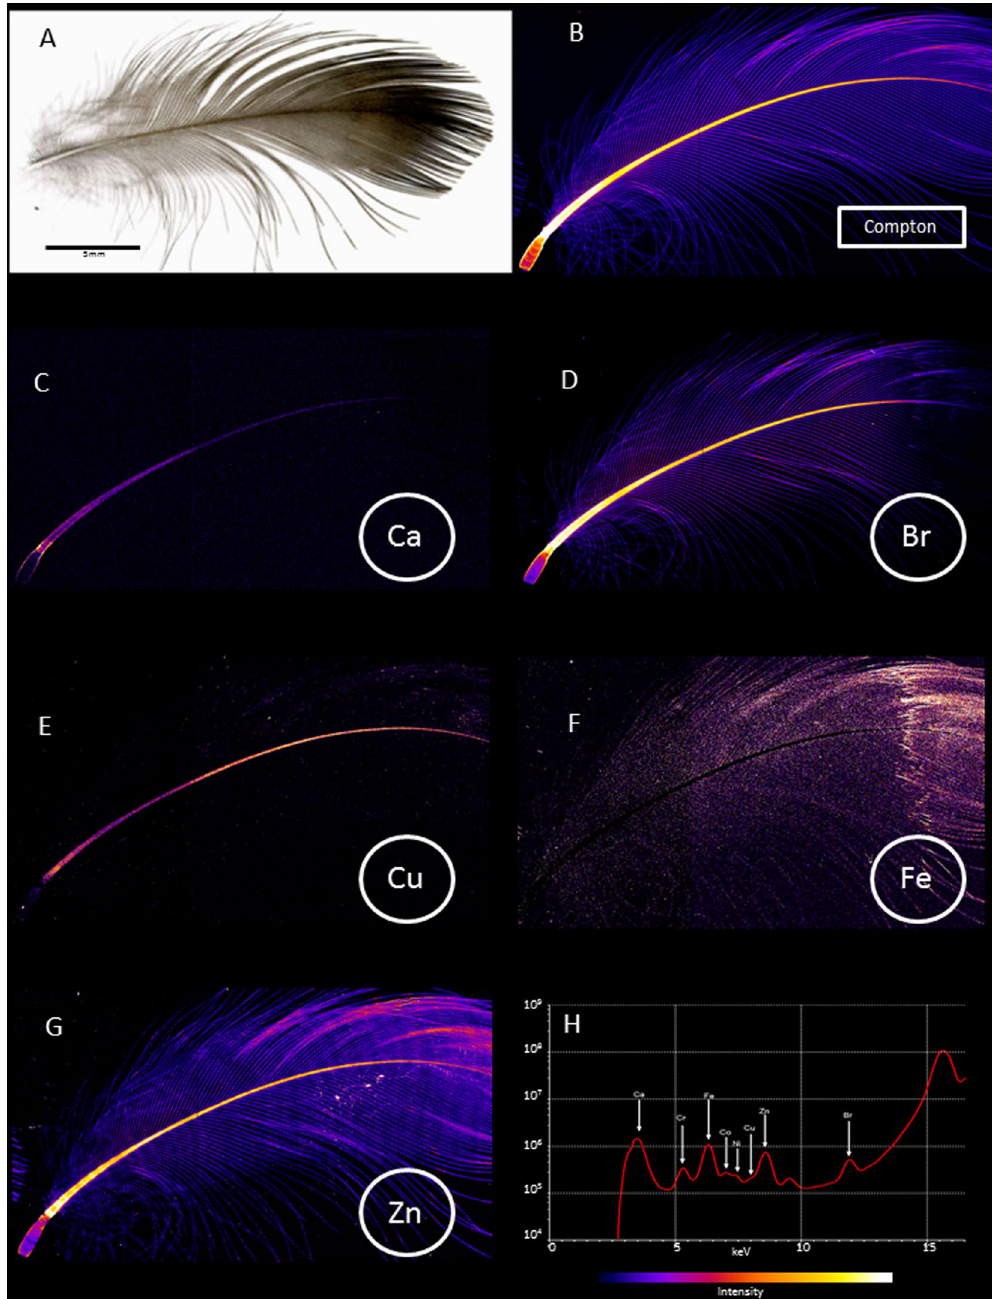
Figure 1. High resolution X-ray fluorescence microscopy images of elemental distributions within a breast feather from a Flesh-footed Shearwater ( Ardenna carneipes ). ( A ) Photographic image of a sample feather; ( B ) reconstructed Compton inelastic scatter; ( C ) Ca distribution; ( D ) Br distribution; ( E ) Cu distribution; ( F ) Fe distribution; ( G ) Zn distribution; ( H ) typical X-ray fluorescence spectrum obtained from Flesh-footed Shearwater breast feathers. The maximum values for the observed elements are; Ca, 7650 ppm; Cu, 113 ppm; Zn, 488 ppm; Br, 279 ppm; Fe, 345